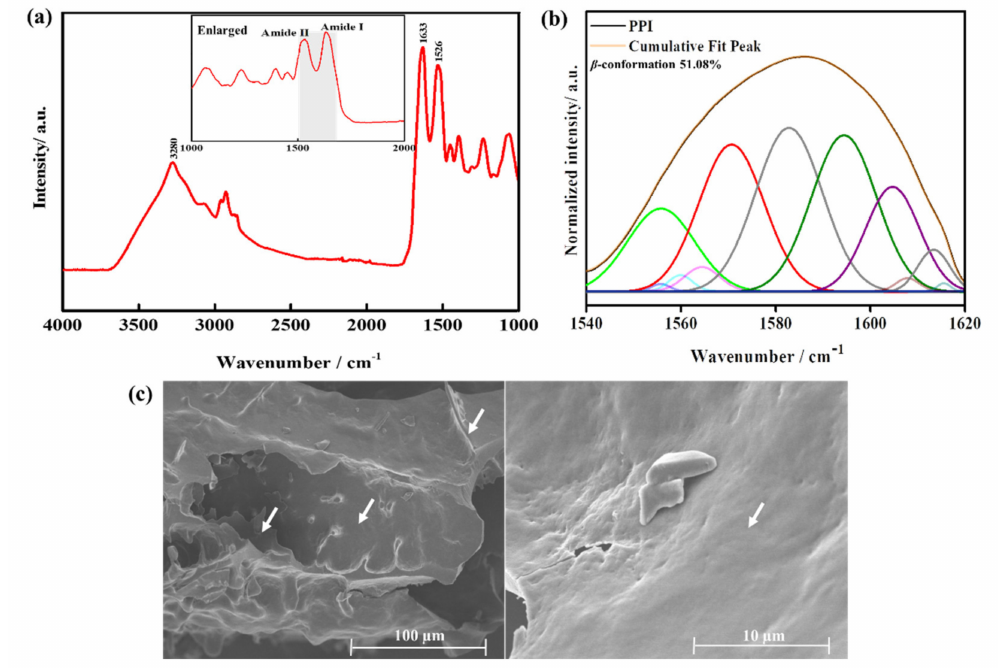
Figure 2. Chemical characterization of PPI. ( a ) The FTIR spectrum of the PPI extracted from the insect, ( b ) curve-fitted amide I and II region (1540–1620 cm − 1 ), and ( c ) FE-SEM morphology of freeze-dried PPI; the white arrows (left to right) indicate the rough, appendicular ridges, and the smooth surfaces present throughout indicate the protein isolate,